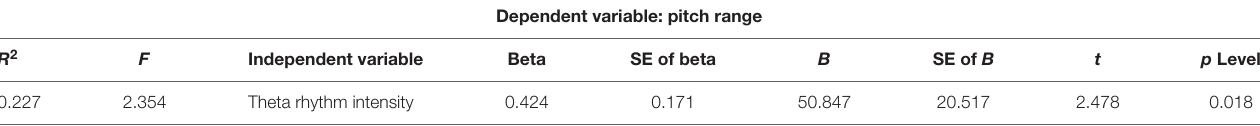
TABLE 7 | Result of multiple regression analysis: EEG characteristics—theta rhythm intensity/pitch